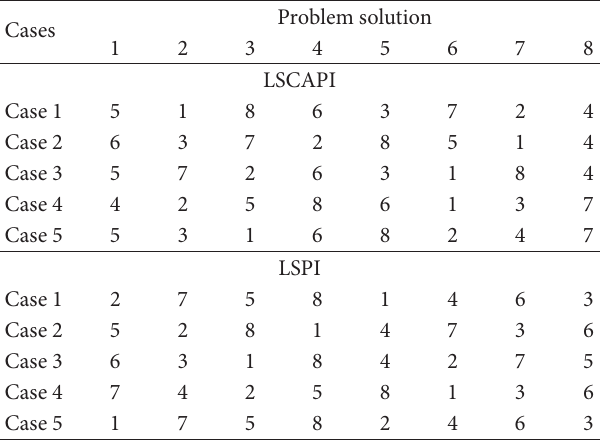
Figure 12: 7th queen. Table 1: Problem solution using LSPI versus